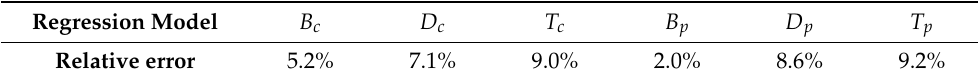
Table 5. Relative